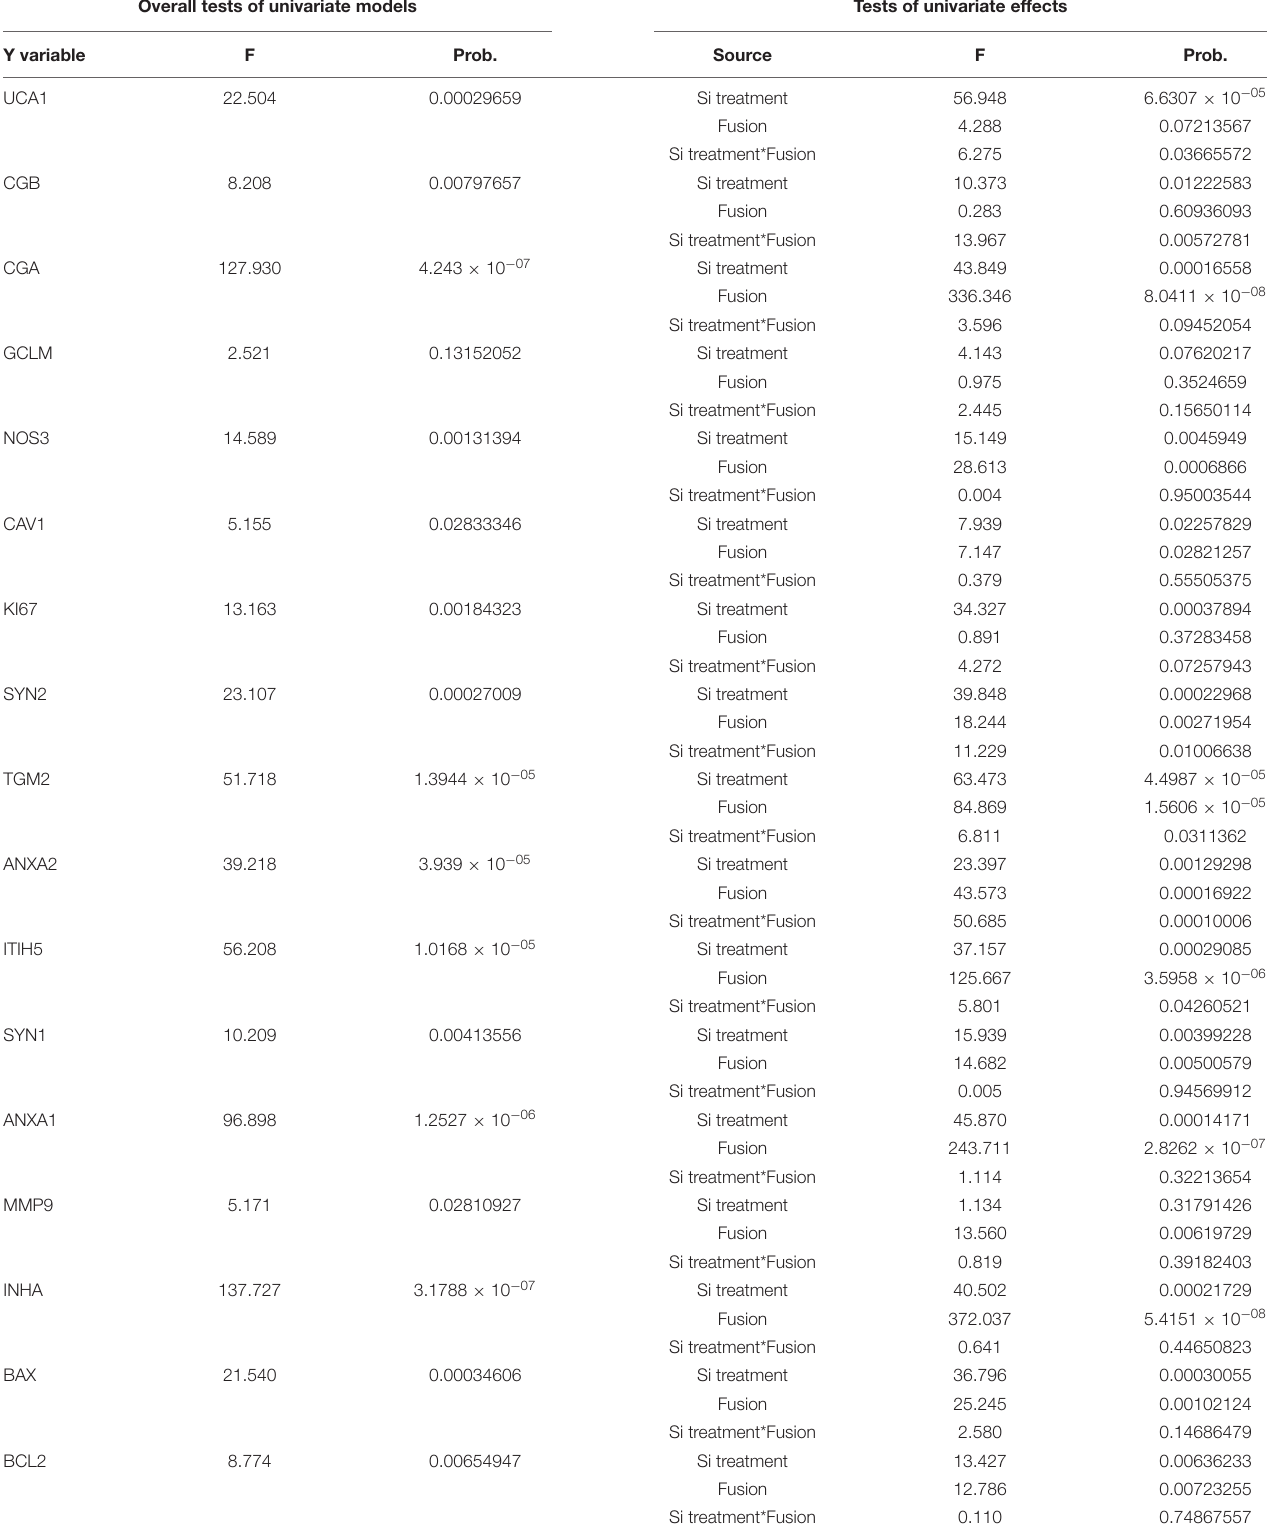
TABLE 3 | Statistical analyses of individual gene effects following UCA1 knock-down ± FSK treatment (significant values are in red fonts). Overall tests of univariate models Tests of univariate